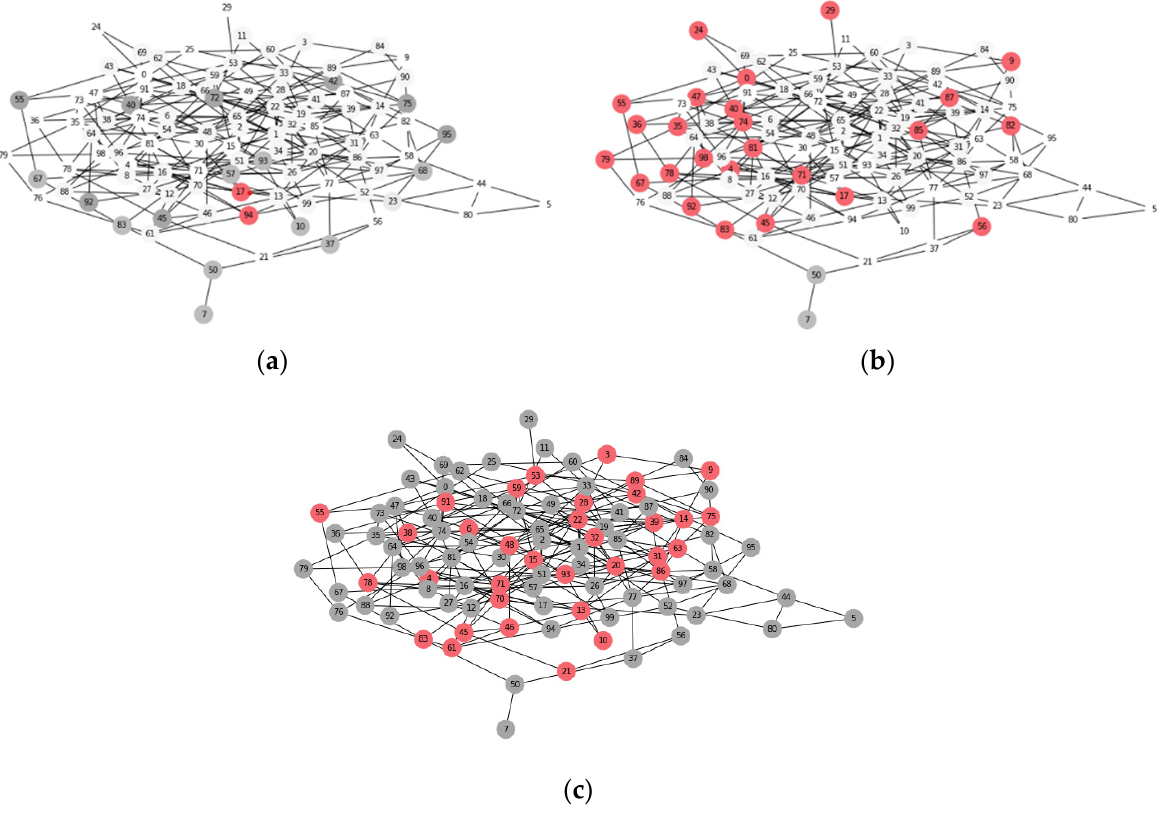
Figure 6. Reliable area identification under the malicious node attacks. ( a ) Single malicious node: 17; ( b ) Double malicious nodes: 6 and 29; ( c ) triple malicious nodes: 14, 38, and 56.